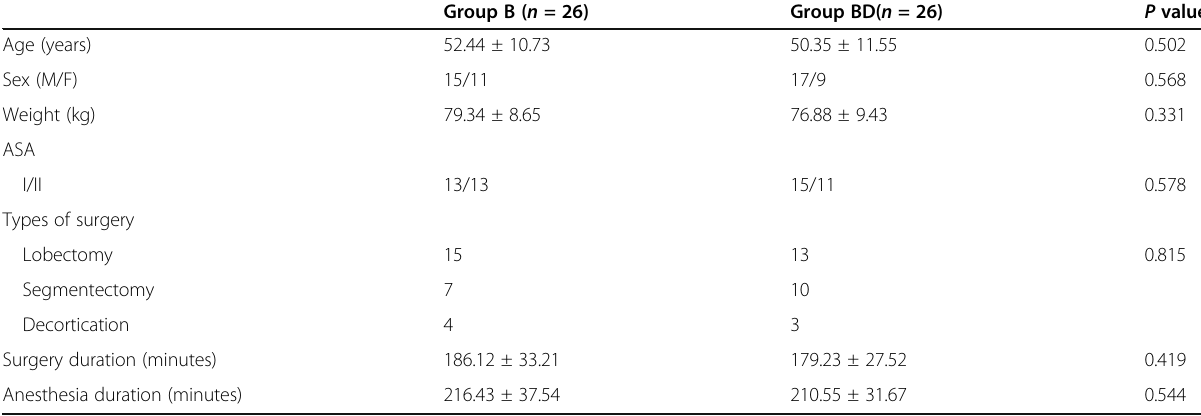
Table 1 Patients ’ and surgery